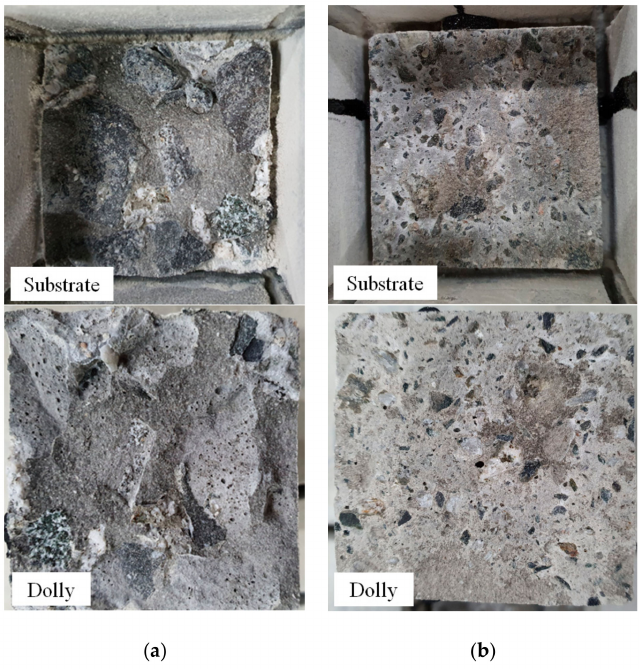
Figure 6. Typical failure modes: ( a ) mortar failure; ( b ) interface